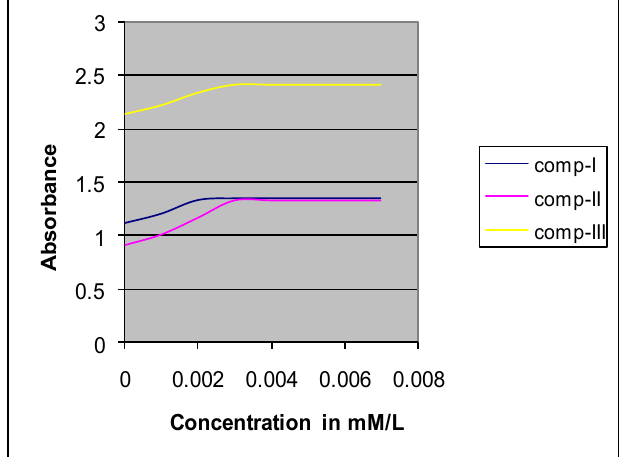
Figure 1: Phase solubility plot of Compound I, II and